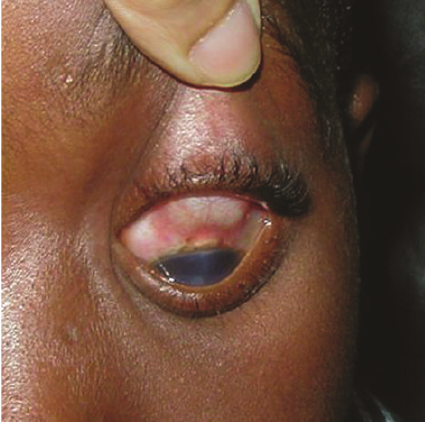
Figure 1: External photograph showing a superior conjunctival bleb in the left eye.